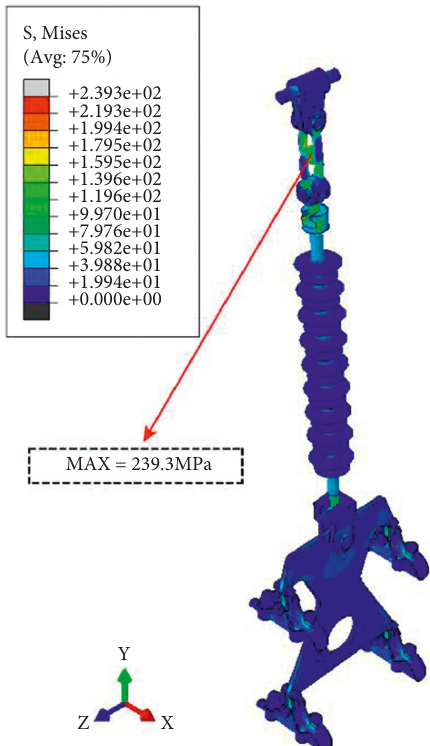
Figure 29: Stress cloud picture of suspension string.